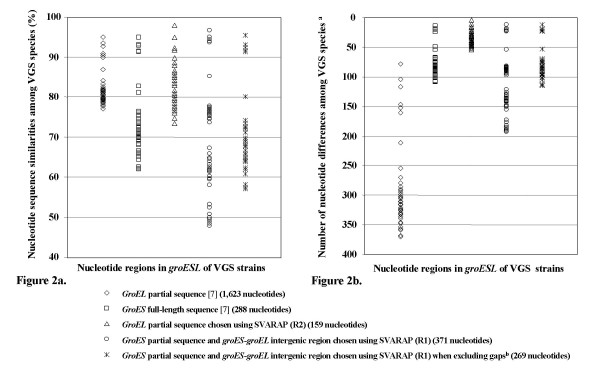
Nucleotide sequence similarities (figure 2a) and numbers of nucleotide differences (figure 2b) among VGS species when analyzing groEL and groES sequences from the study by Teng et al [7], or regions R1 and R2 chosen using SVARAP to discriminate between the different VGS species. a For sequences obtained by Teng et al., the numbers of nucleotide differences among VGS species were calculated based on the nucleotide sequence similarities and the sequence lengths published [7]. b Partial groES-including sequences chosen using SVARAP (R1) were analysed to calculate sequence similarities considering or not considering positions in the alignment where at least one sequence does not harbor a nucleotide (gaps).